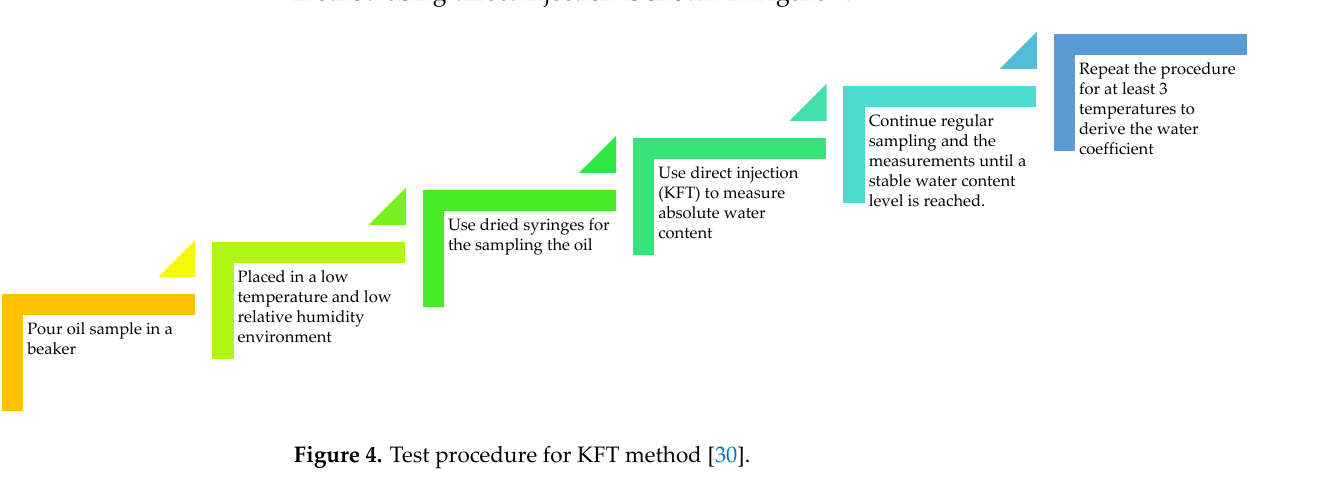
Figure 4. Test procedure for KFT method [30].